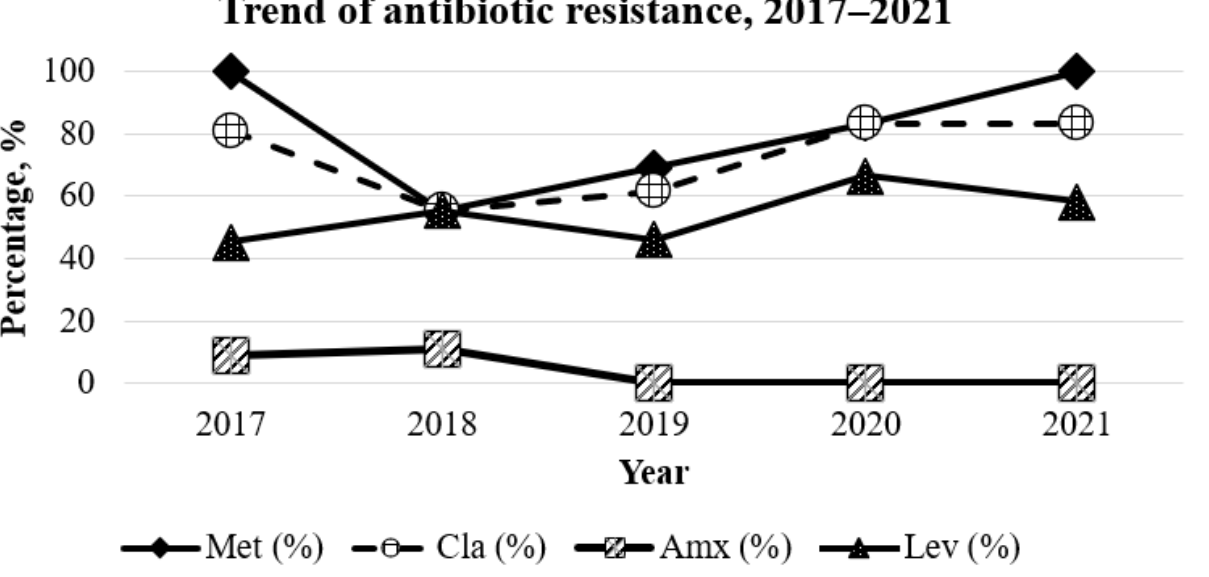
Figure 1. Trend in secondary antibiotic resistance from 2017–2021.